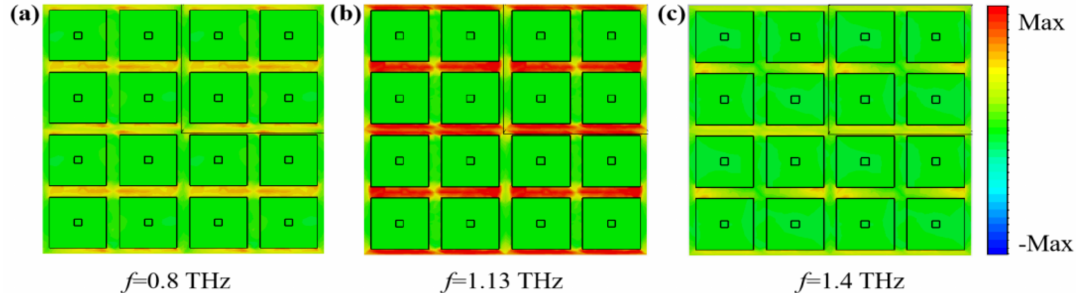
Figure 3. Electric field distribution on the VO 2 square ring structure at ( a ) 0.8 THz, ( b ) 1.13 THz, and ( c ) 1.4 THz